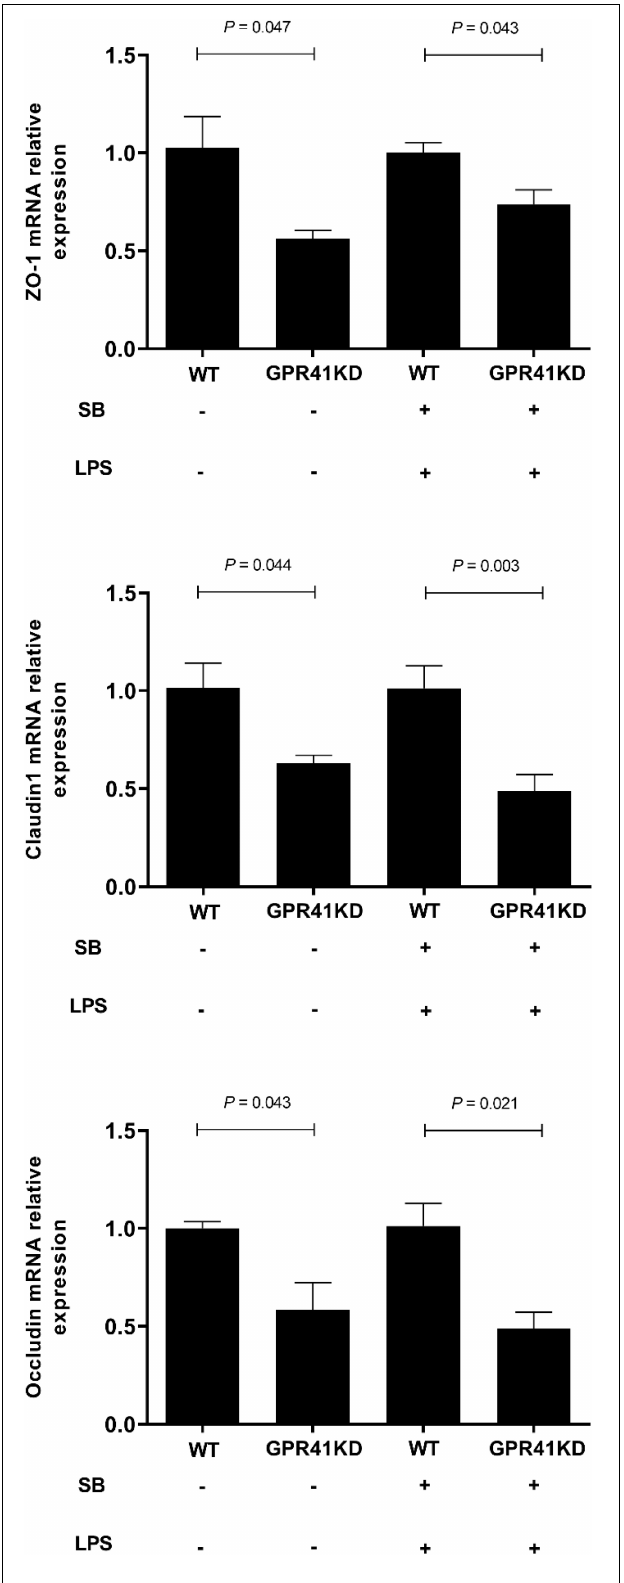
FIGURE 8 | Effect of GPR41 on the gene expression of tight junction proteins. Generation of GPR41-knockdown (GPR41KD) BREC cell lines using the CRISPR/Cas9 system. Pretreatment with sodium butyrate (SB) in BRECs and BRECEs–GPR41KD for 18 h, then treated with 4 µ g/mL LPS for 6 h. After incubation, cells were analyzed by qRT-PCR. The values are shown as mean ± SEM ( n =